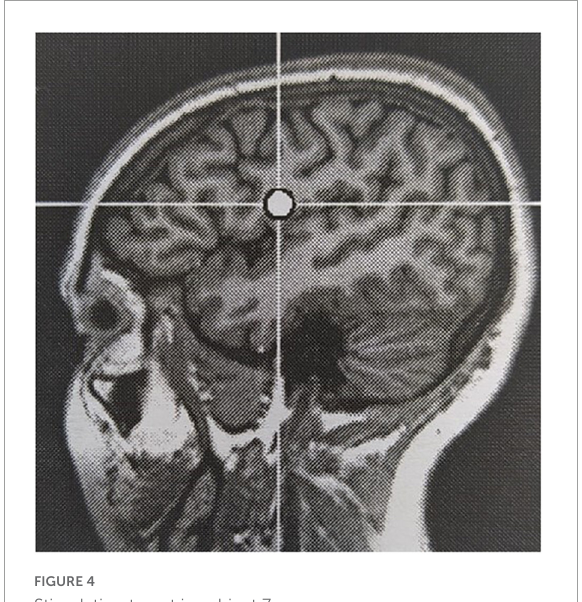
FIGURE4 Stimulation target in subject